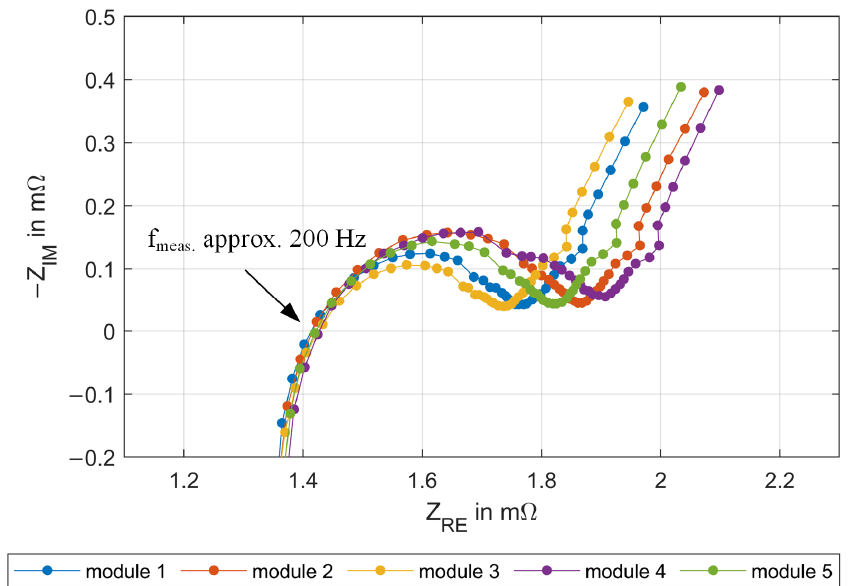
Figure 10. Battery impedance spectra of an NMC ‐ based Li ‐ ion battery at various SOH levels and 30% SOC (adapted from [37], licensed under CC BY 4.0).